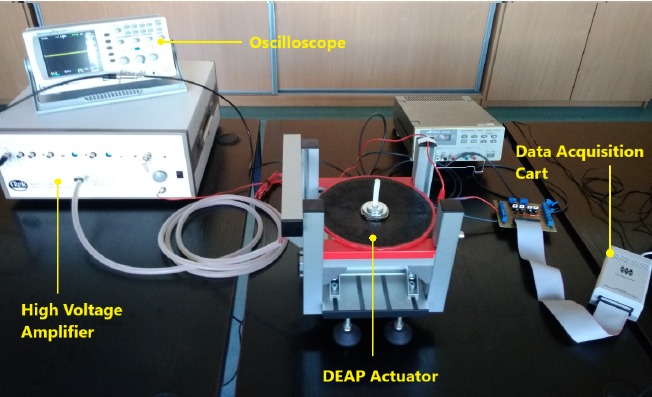
Figure 8. The laboratory kit with a DEAP actuator, a high-voltage amplifier, and a data acquisi- tion